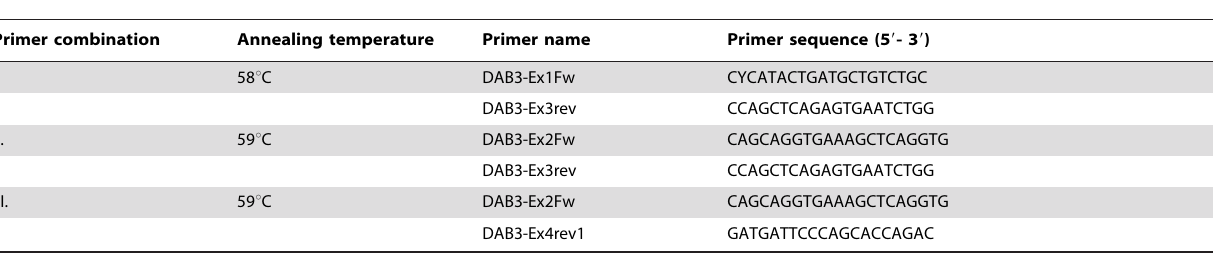
Table 1. PCR conditions and details on primers used for DAB3